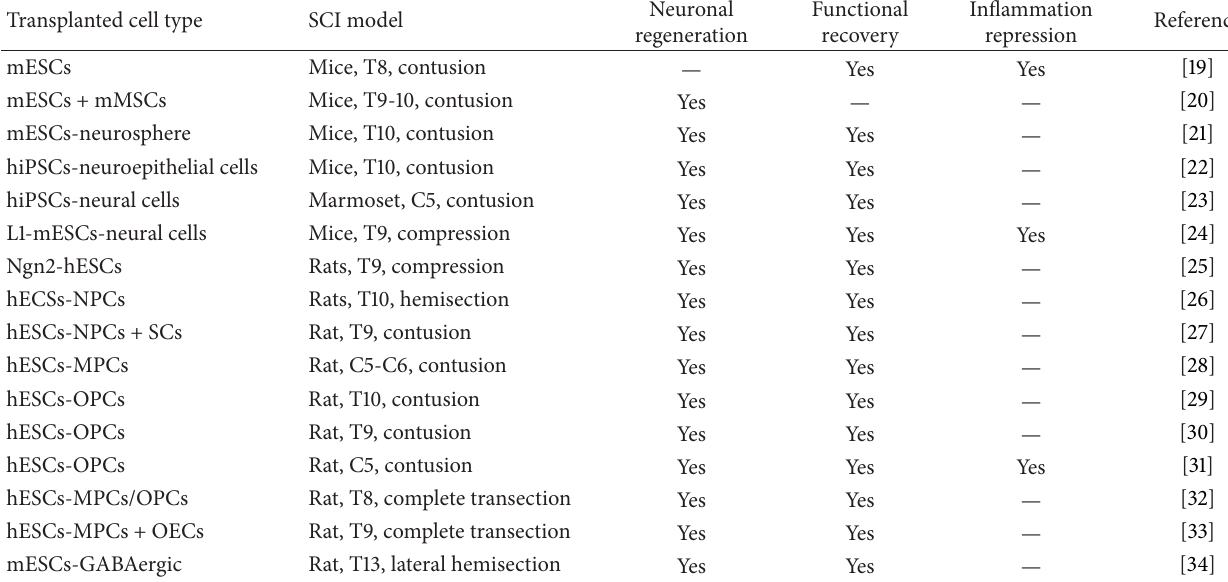
Table 1: Preclinical spinal cord injury trials using induced pluripotent stem cells (iPSCs)/embryonic stem cells (ESCs). Transplanted cell